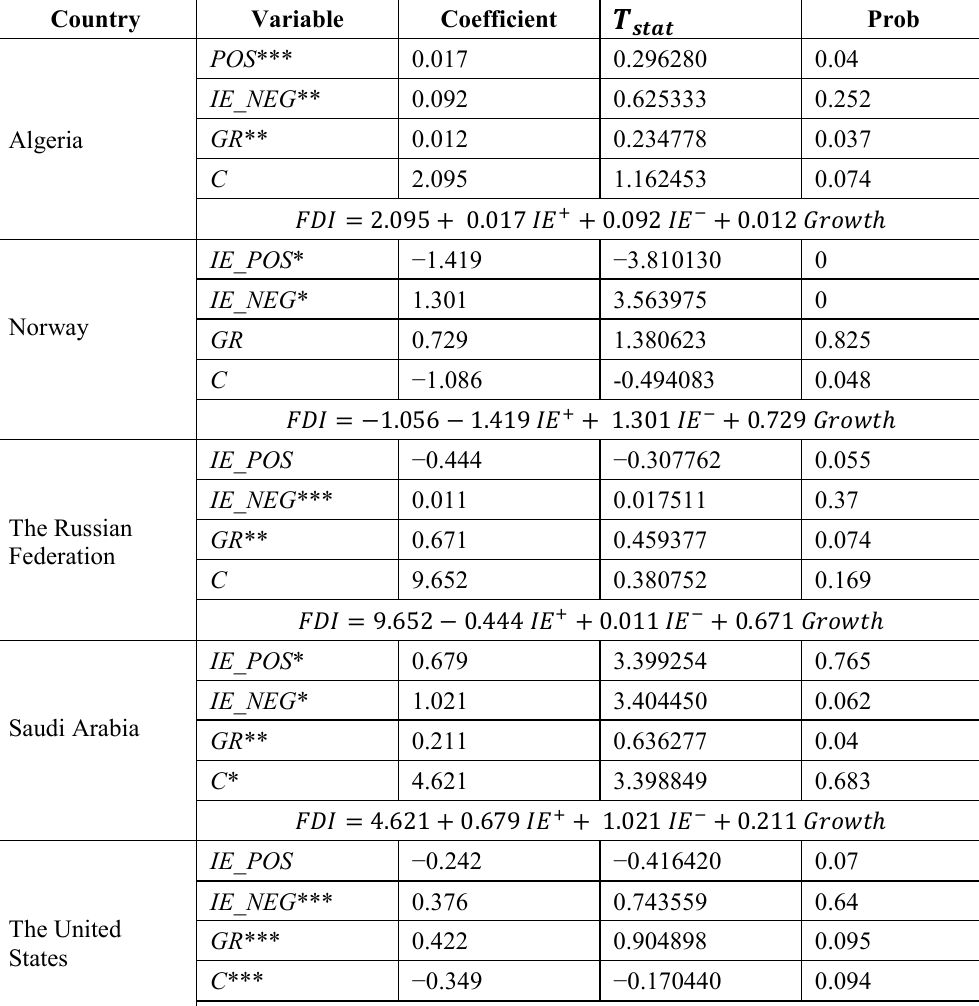
Table 7. NARDL Models for Long-run